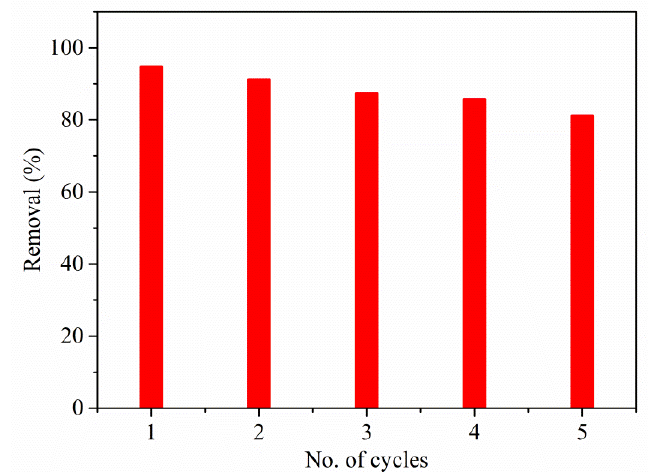
Figure 10. Reusability study for RO16 by Cu(I)-PANI composite (initial concentration, pH, dosage, contact time, and solution volume are 100 mg/L, 4, 0.06 g/L, 100 min, and 100 mL, respectively).